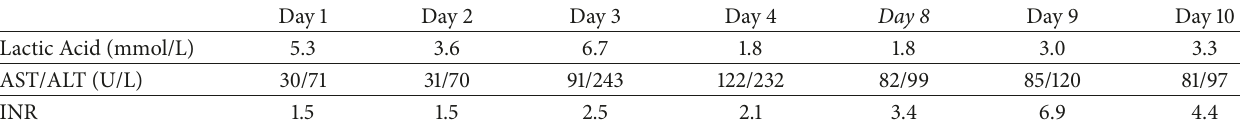
Table 1: Outline of pertinent lactic acid, liver enzymes, and INR throughout hospitalization.